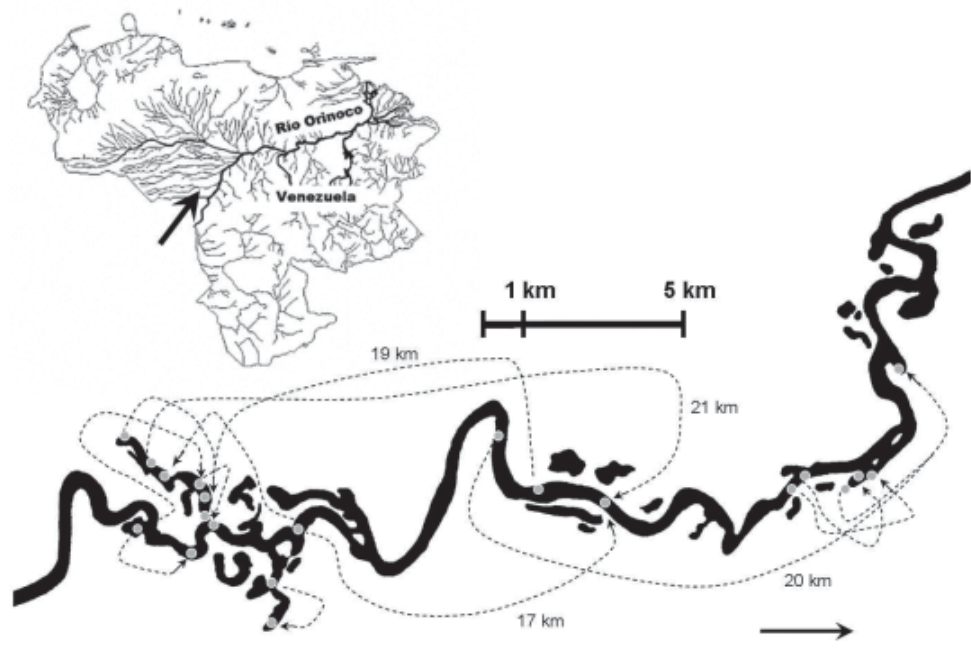
Fig. 1. Map of Venezuelan rivers with arrow depicting location of the Cinaruco River in the Orinoco River drainage. Dashed arrows illustrate movements of individuals recaptured more than 750 m from their tagging location. Flow is in the direction of the arrow at bottom right.